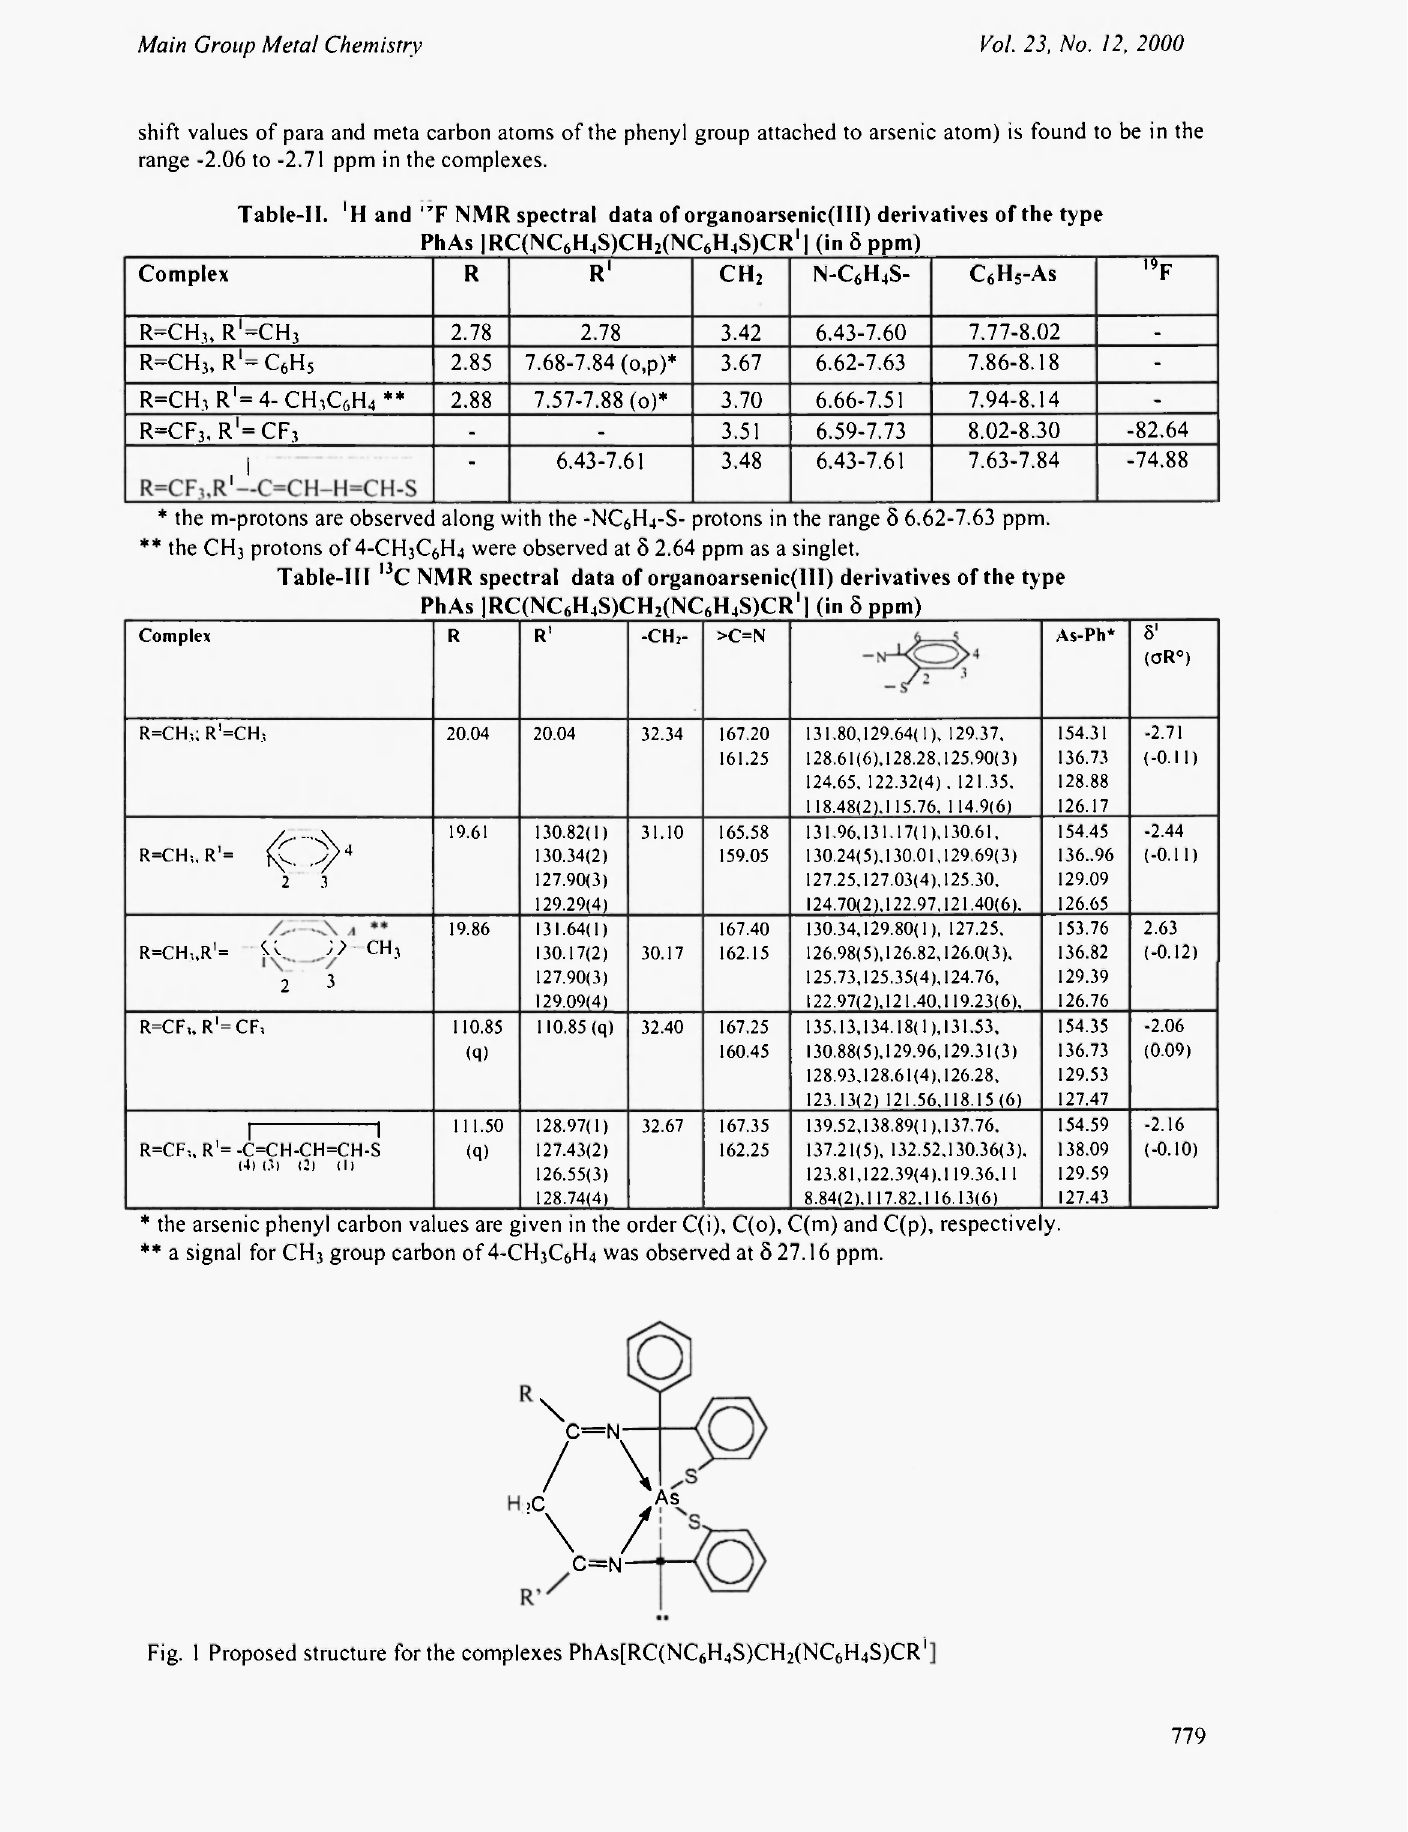
Table-II. 'H and F NMR spectral data of organoarsenic(III) derivatives of the type